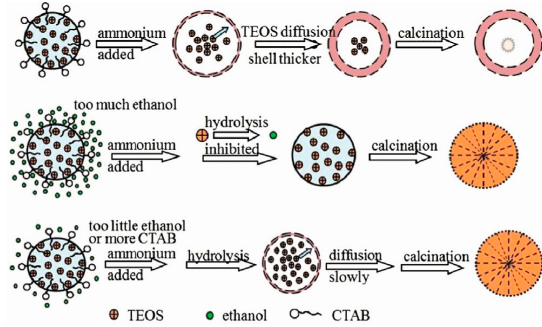
Figure 3. Schematic illustrations for the controllable synthesis of silica hollow sphere [67].